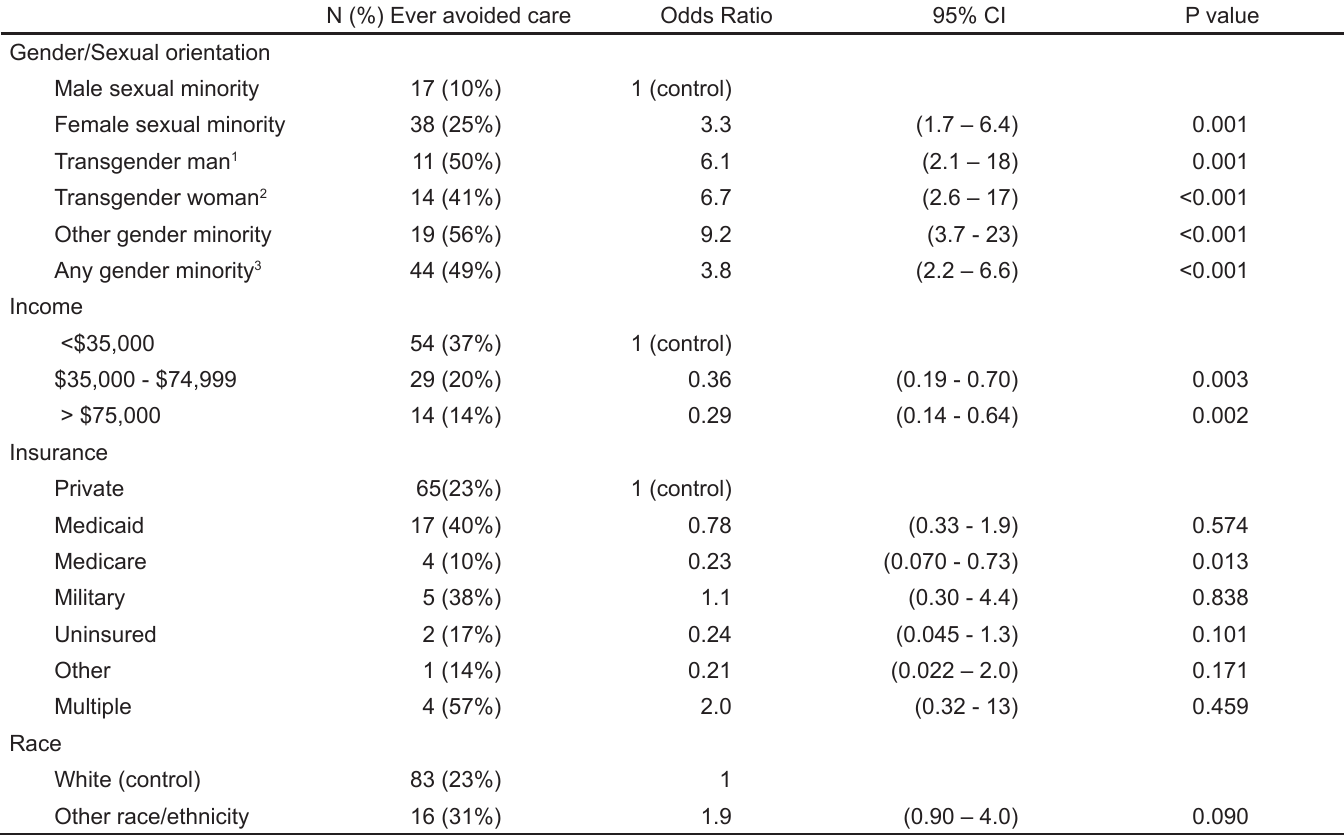
Table 2. Odds of ever avoiding care generated by logistic